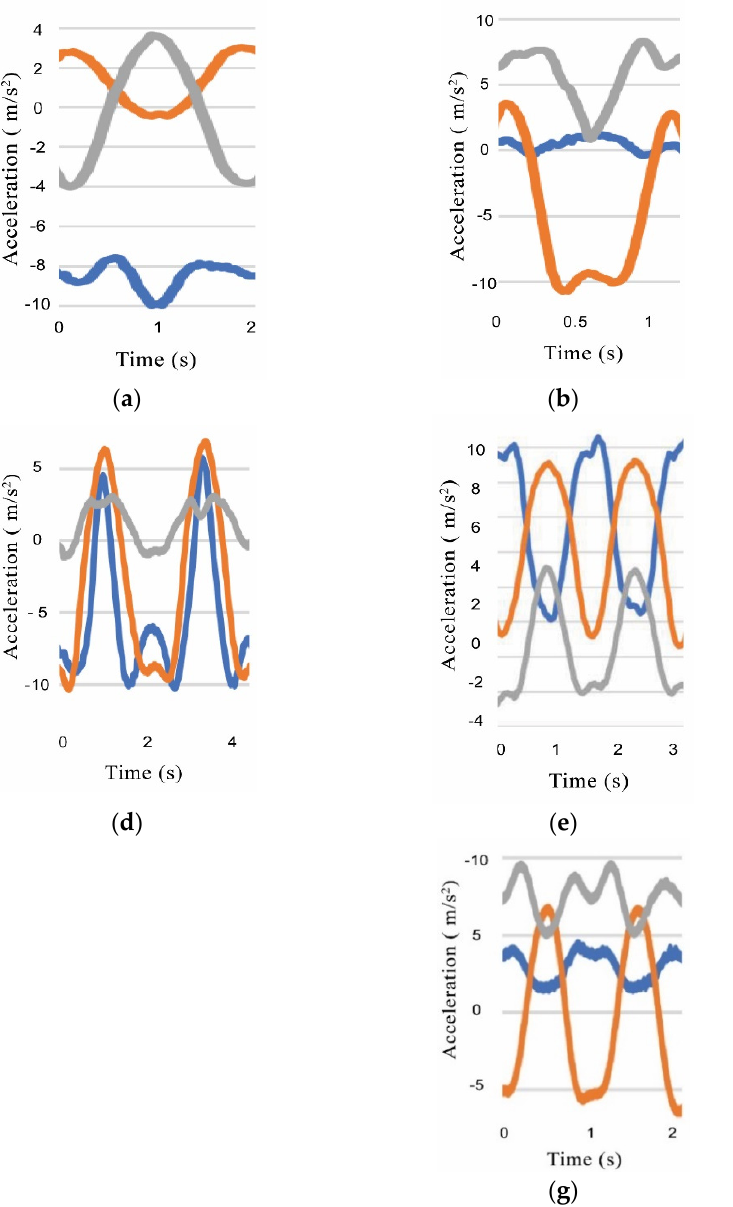
Figure 6. Acceleration signal of two consecutive peaks corresponding to: ( a ) Single extension; ( b ) Single IR; ( c ) Two abductions; ( d ) Two flexions; ( e ) Two elbow extensions (EEs); ( f ) Two elbow flexions (EFs); and ( g ) Two external rotations (ERs).